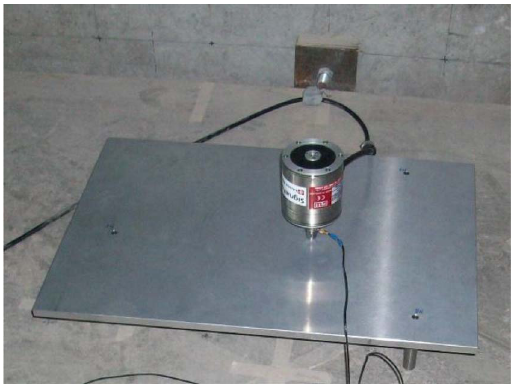
Figure 1. RRRS (round robin reference source) on a low mobility reception plate.